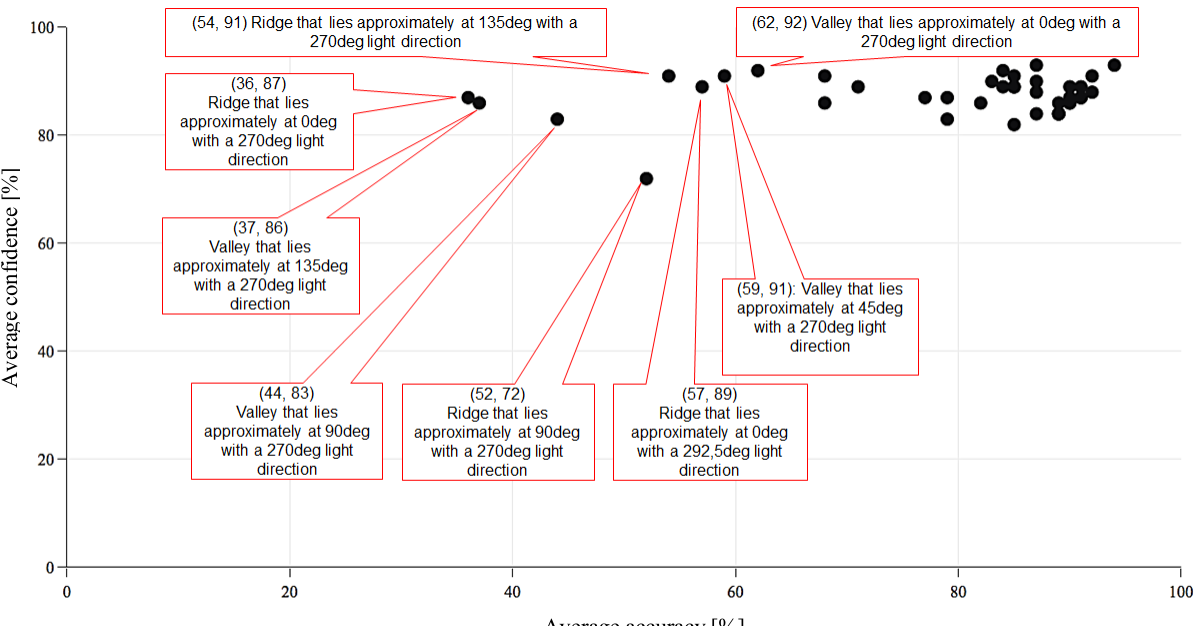
Figure 4. The average accuracy scores of the participants compared to the average confidence score (per question). We annotated the plot to demonstrate low score – high confidence pairings. A clear pattern emerges from this clustering: even when the accuracy rates are low, participants are highly confident. Specifically, when the light source is placed at 270 o , participants feel confident (~over 70%) even though their accuracy in landform identification is low (~under